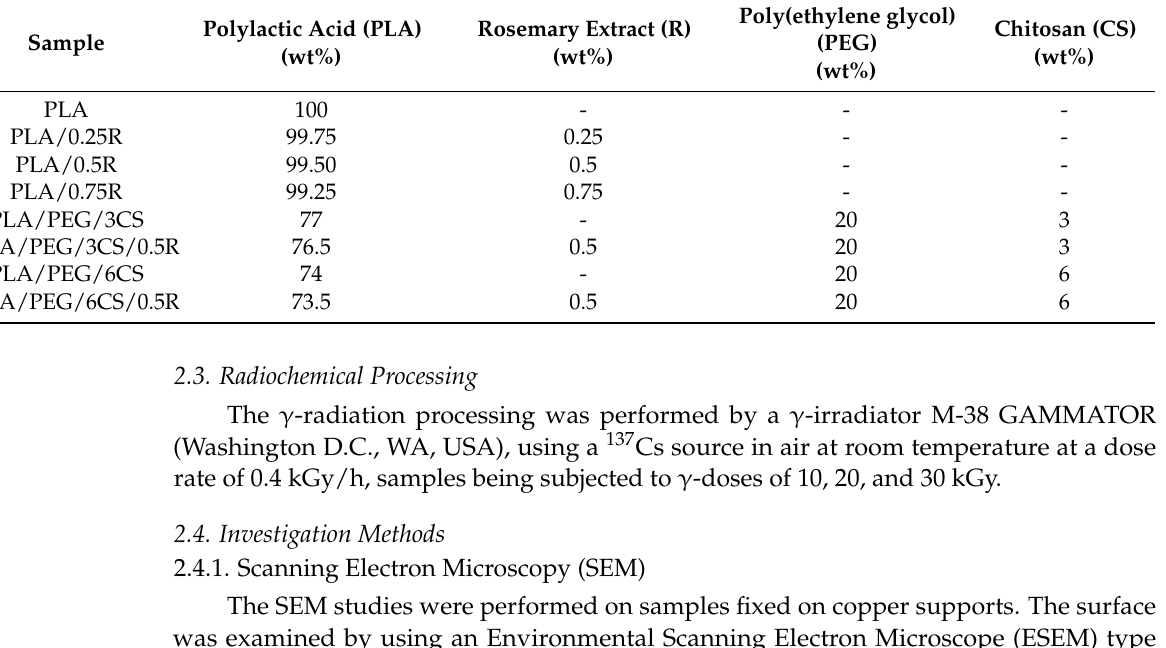
Table 1. Compositions of the studied PLA-based